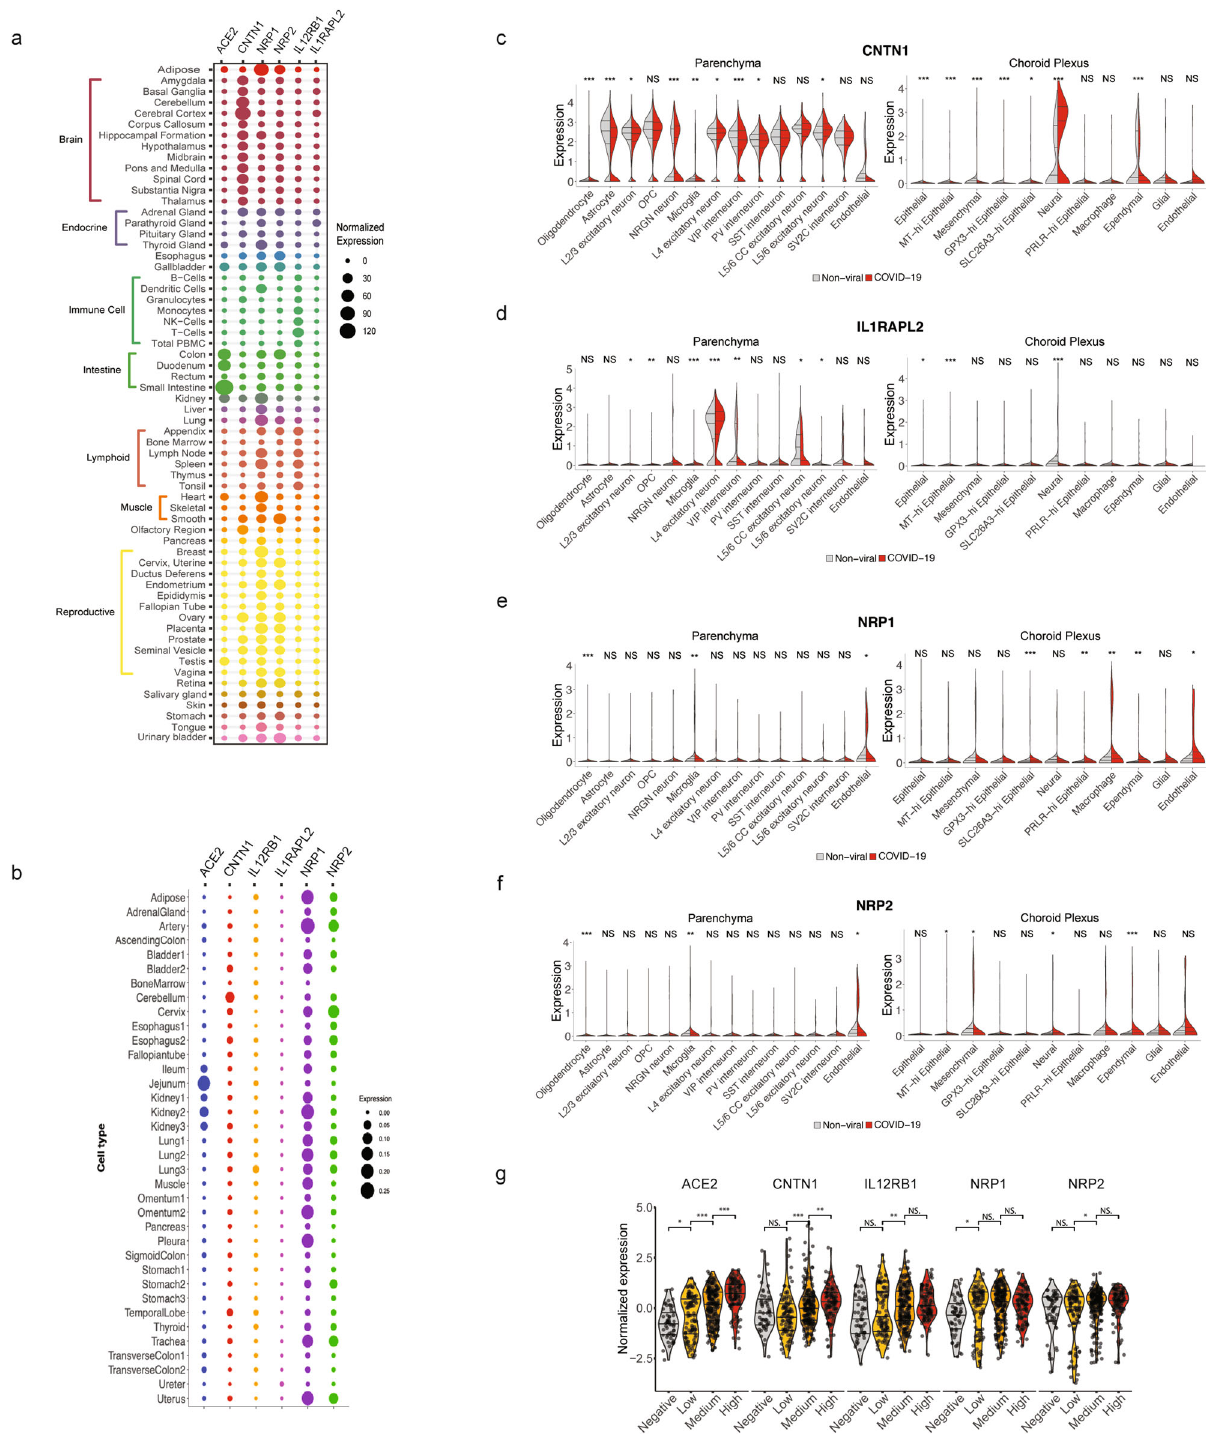
Fig. 5 The SARS CoV-2 spike binding partners are expressed in multiple tissues and dysregulated in COVID-19 patients. a Expression of SARS CoV-2 spike binding partners across human tissues indicated by different colors (RNAseq data from Human Protein Atlas). b Dotplot showing scRNAseq expression of ACE2 and the additional RBD binders IL12RB1, IL1RAPL2, NRP2, CNTN1 and the related protein NRP1 in 36 different tissue types in healthy individuals. scRNAseq data was obtained from GSE13455. c – f Split violin plots showing the differential gene expression of ( c ) CNTN1; ( d ) IL1RAPL2; ( e ) NRP1 and ( f ) NRP2, between non-viral and COVID-19 infected individuals in each cell type collected from choroid plexus and parenchyma. Statistical signi fi cance between low, medium and high viral load is calculated by Mann Whitney U test adjusted by Benjamini-Hochberg correction. * p < 0.05, ** p < 0.01, *** p < 0.001. NS, Not signi fi cant. Single nucleus RNAseq data for C-F was obtained from twc-stanford.shinyapps.io/scRNA_Brain_COVID19. g Violin plots of ACE2, CNTN1, NRP1, NRP2 and IL12RB1 expression by viral load in nasopharynx from healthy individuals and COVID-19 patients ( n = 430 positive, 54 negative). Each dot represents an individual sample. Statistical signi fi cance between low, medium and high viral load is calculated by Mann Whitney U test, * p < 0.05, ** p < 0.01, *** p < 0.001. NS, Not signi fi cant. RNAseq data was obtained from